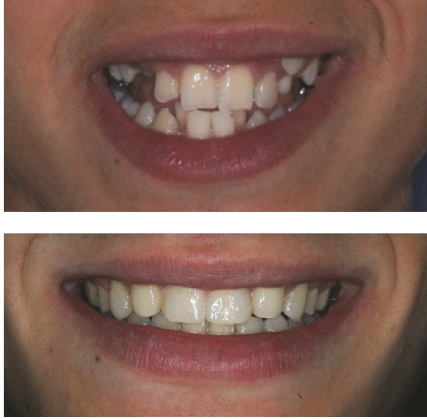
Figure 5: Initial and final smile photographic